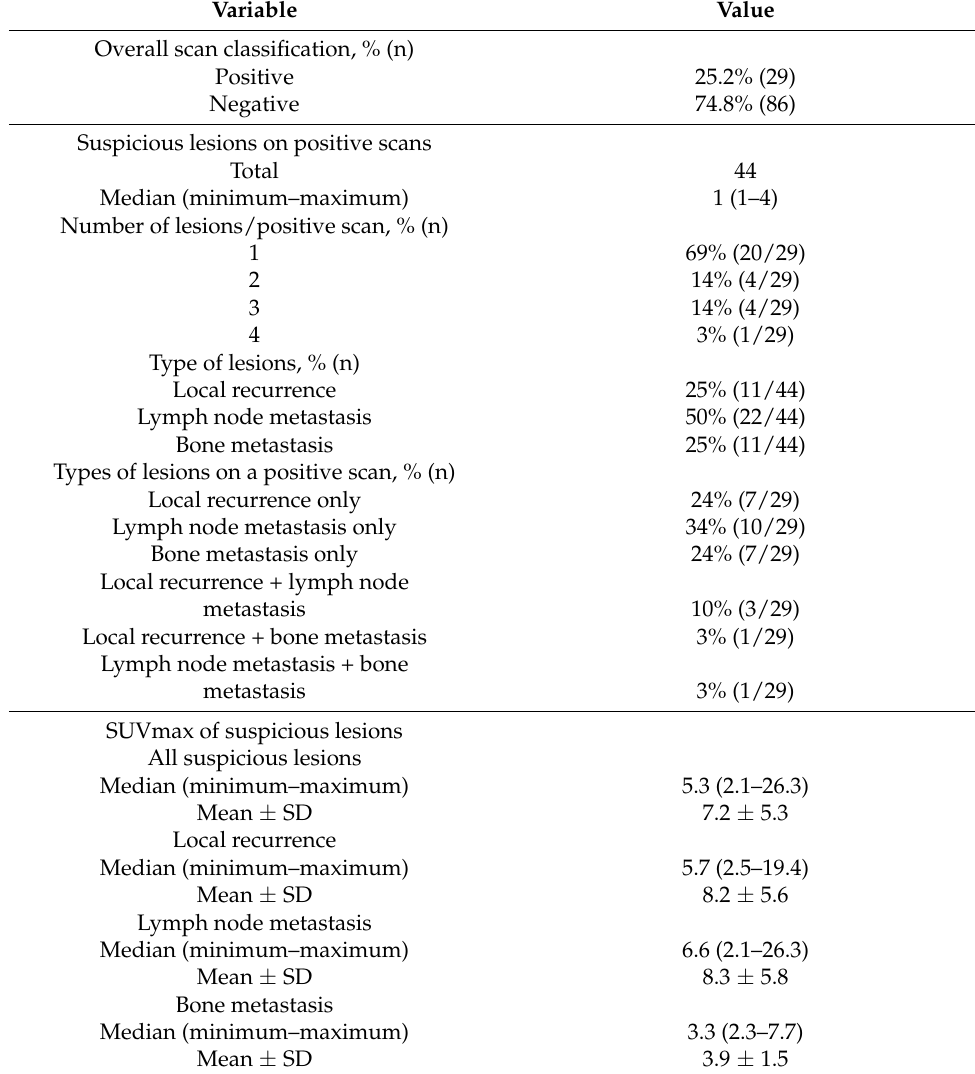
Table 2. 68 Ga-PSMA-11 PET/CT findings in 115 men with BCR and very low PSA